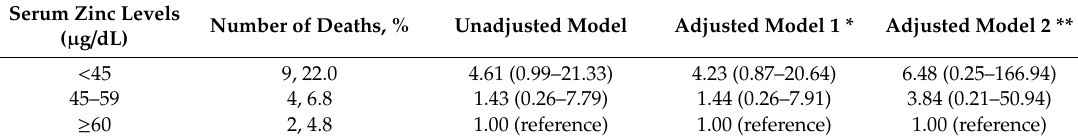
Table 3. Relationship between baseline serum zinc levels and hazard ratios of all-cause mortality. Serum Zinc Levels ( µ g /